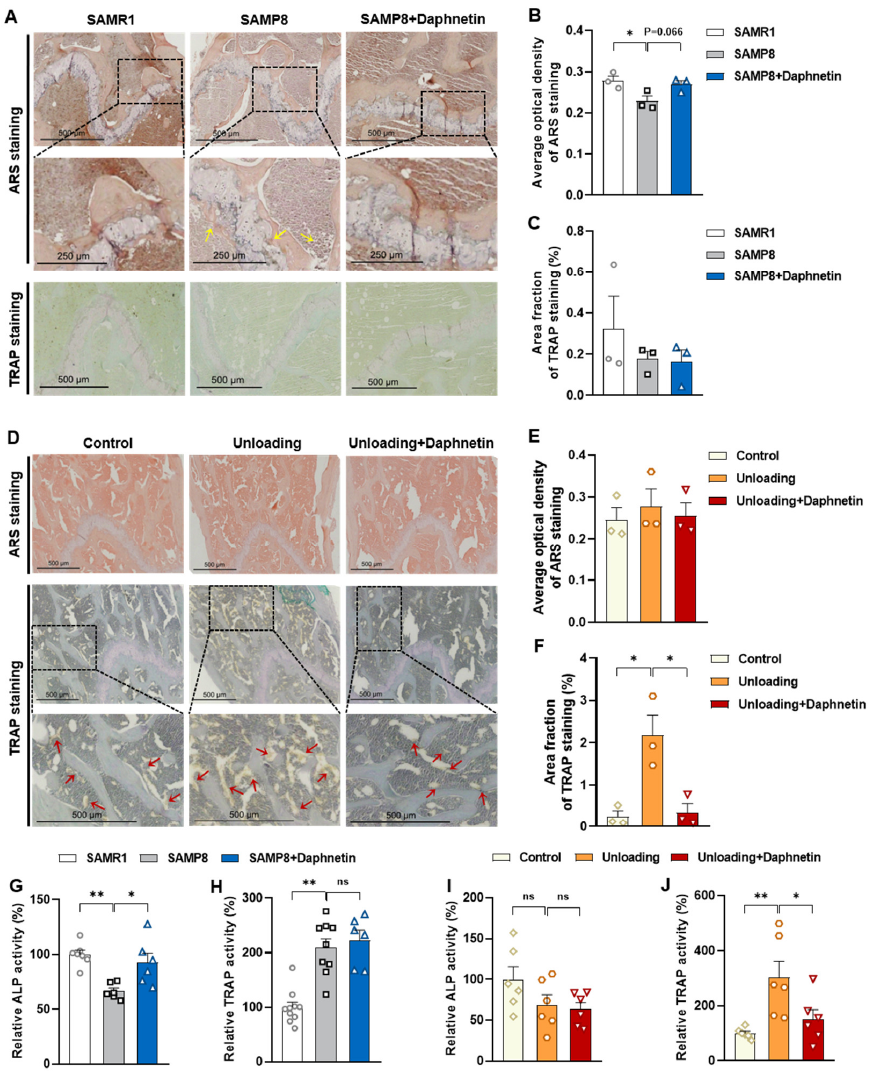
Figure 4. Histological observation and activity assay of bone formation and resorption in SAMP8 and hindlimb unloading mice with daphnetin administration. ARS staining and TRAP staining were performed on femur sections. ( A ) Images of ARS and TRAP staining of SAMP8 mice. ( D ) Images of ARS and TRAP staining of hindlimb unloading mice. ( B , E ) Statistical analysis of ARS staining was performed with ImageJ software ( n = 3). ( C , F ) Statistical analysis of TRAP staining was performed with Image-Pro Plus software ( n = 3). In SAMP8 mice, ALP activity ( G ) and TRAP activity ( H ) of bone homogenates were determined with commercial kits. In hindlimb unloading mice, ALP activity ( I ) and TRAP activity ( J ) of bone homogenates were also determined. Data are mean ±S.E.M. ( n ≥ 6); * p < 0.05; ** p < 0.01; ns, not significant.